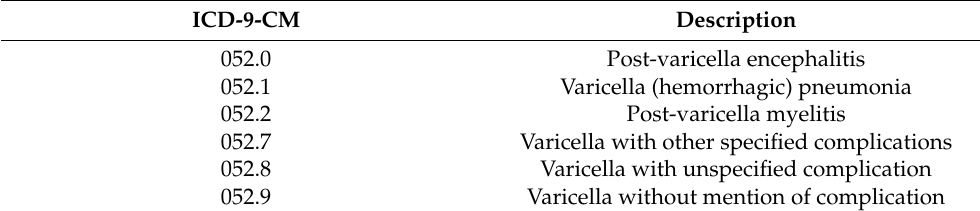
Table 1. ICD-9-CM codes were used to select subjects with